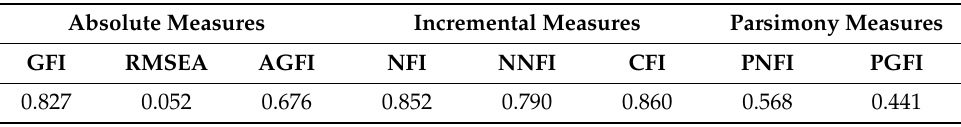
Table 11. GOF for measurement